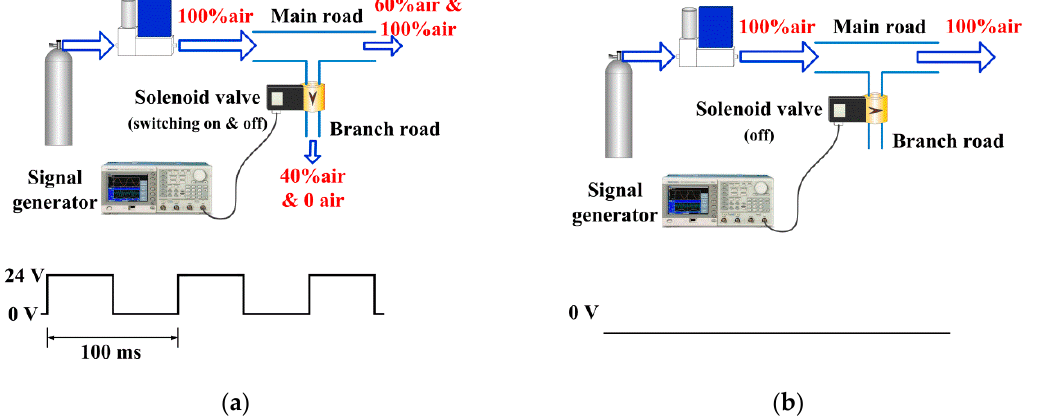
Figure 1. A schematic of the experimental system.